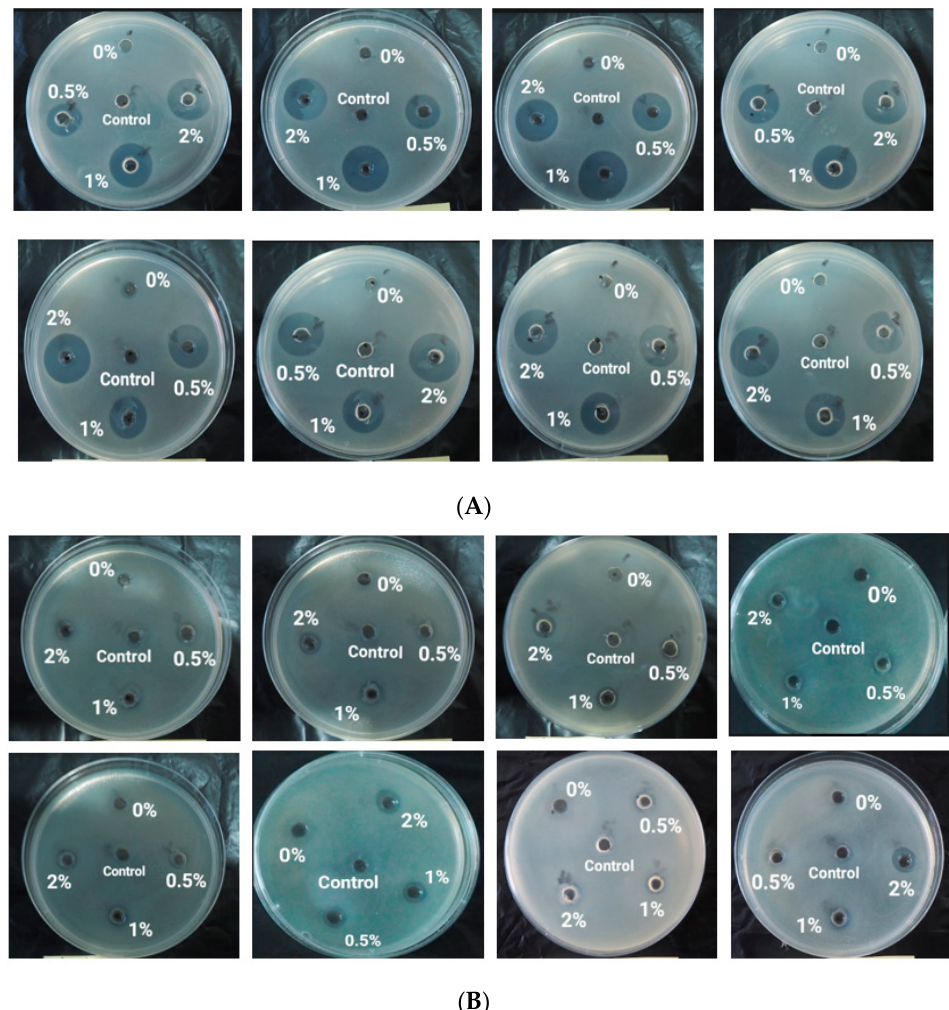
Figure 10. Diameter of inhibition zone of hand sanitizer gel against ( A ) S. aureus and ( B ) E. coli with eight times measurement repetition. Table 3. Antibacterial activity of hand sanitizer gel towards Escherichia coli bacteria.